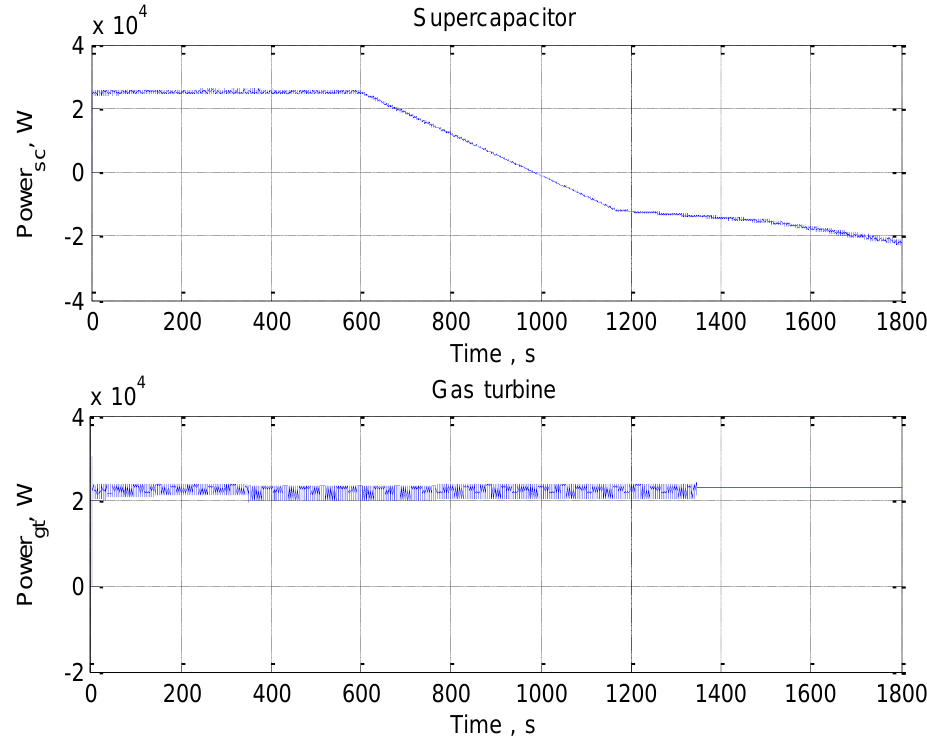
Figure 8. Realized and reference power at C = 500 F.